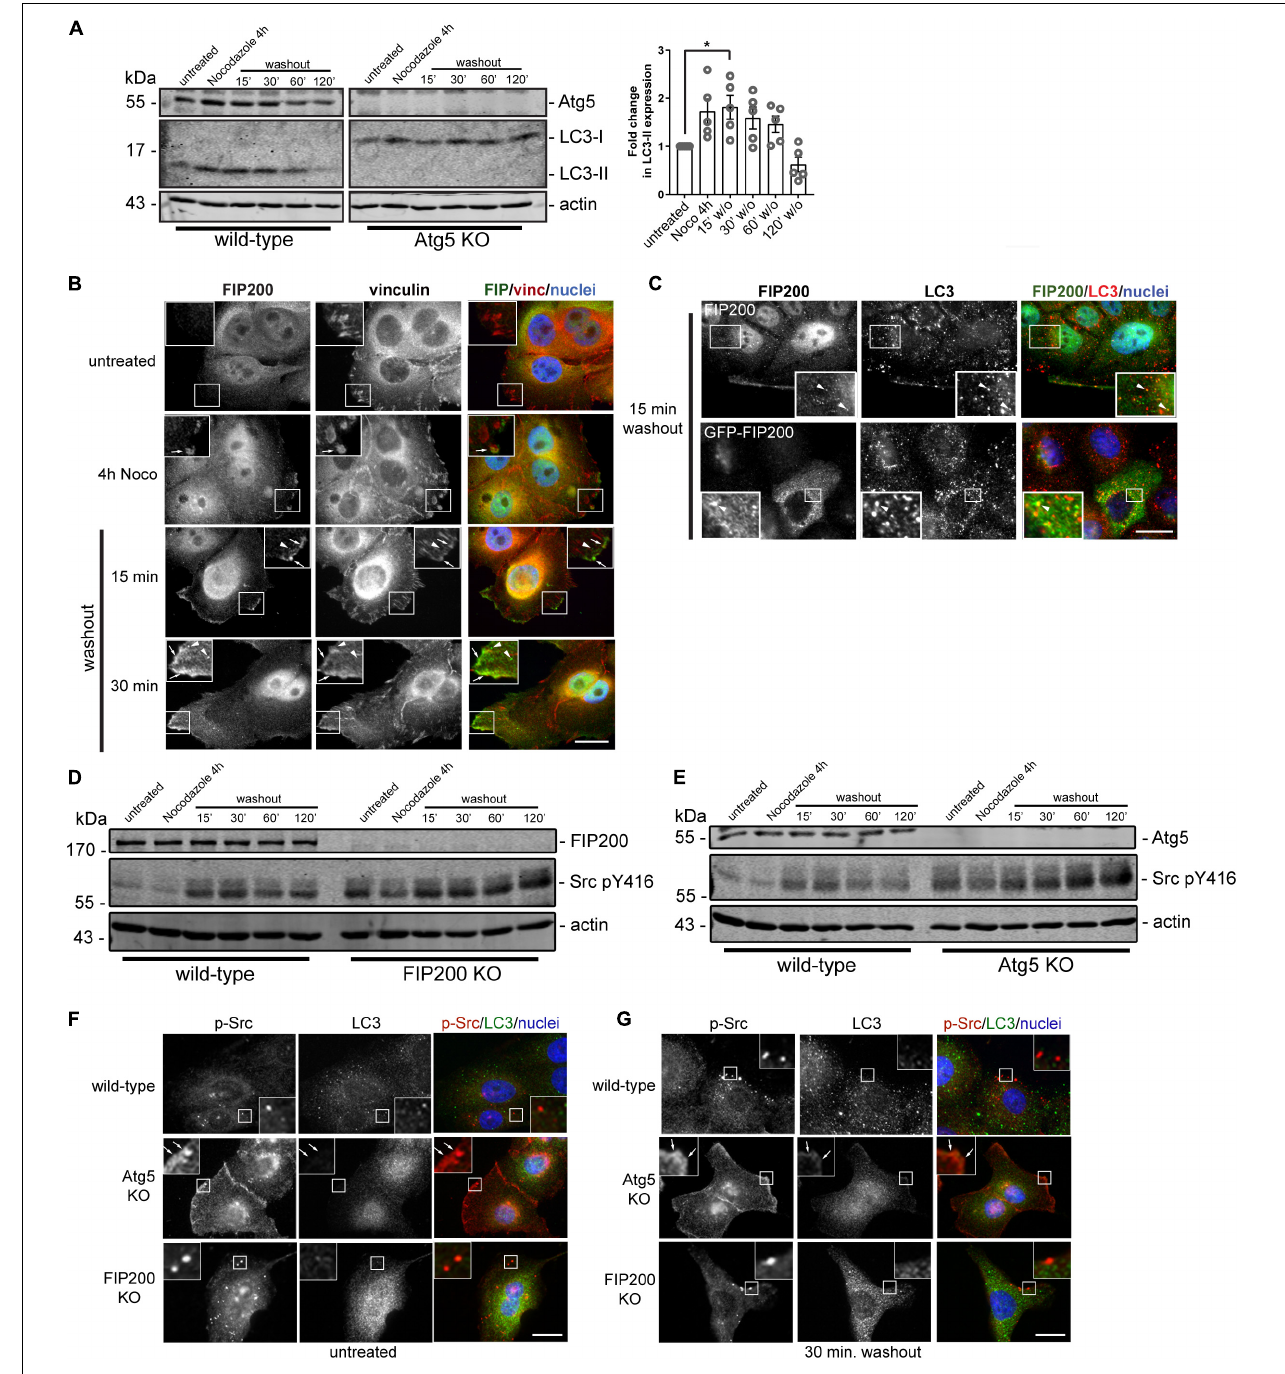
FIGURE 7 | Autophagy is activated during focal adhesion reorganization, which correlates with FIP200 localization to focal adhesions and autophagosomes. (A) Western blot analysis was performed on lysates harvested from MCF10A wild-type and Atg5 KO cells along the time course of the Nocodazole assay. Cells were either left untreated or treated with Nocodazole for 4 hours in serum-free media prior to washout of Nocodazole and recovery in growth media for indicated time points. Immunoblotting was performed against the indicated proteins and fold change in LC3-II levels were quantitated. Graph represents the fold change in LC3-II from untreated control following normalization to actin. One way ANOVA followed by Dunnett’s multiple comparison test was performed, * p < 0.05. Error bars represent the SEM. (B) Immunofluorescence microscopy of FIP200 (green) and vinculin (red) colocalization along selected time points of the Nocodazole assay. Nuclei are labeled with Hoechst (blue). Arrows indicate FIP200 FA-like immunostaining and arrowheads indicate FIP200 vesicular localization. (C) Immunofluorescence microscopy of either endogenous FIP200 or GFP-FIP200 (green) and LC3 (red) in MCF10A cells at 15 min post-Nocodazole washout. Nuclei are labeled with Hoechst (blue). Arrowheads indicate areas of colocalization. (D) Western blot analysis on cell lysates harvested from MCF10A wild-type and